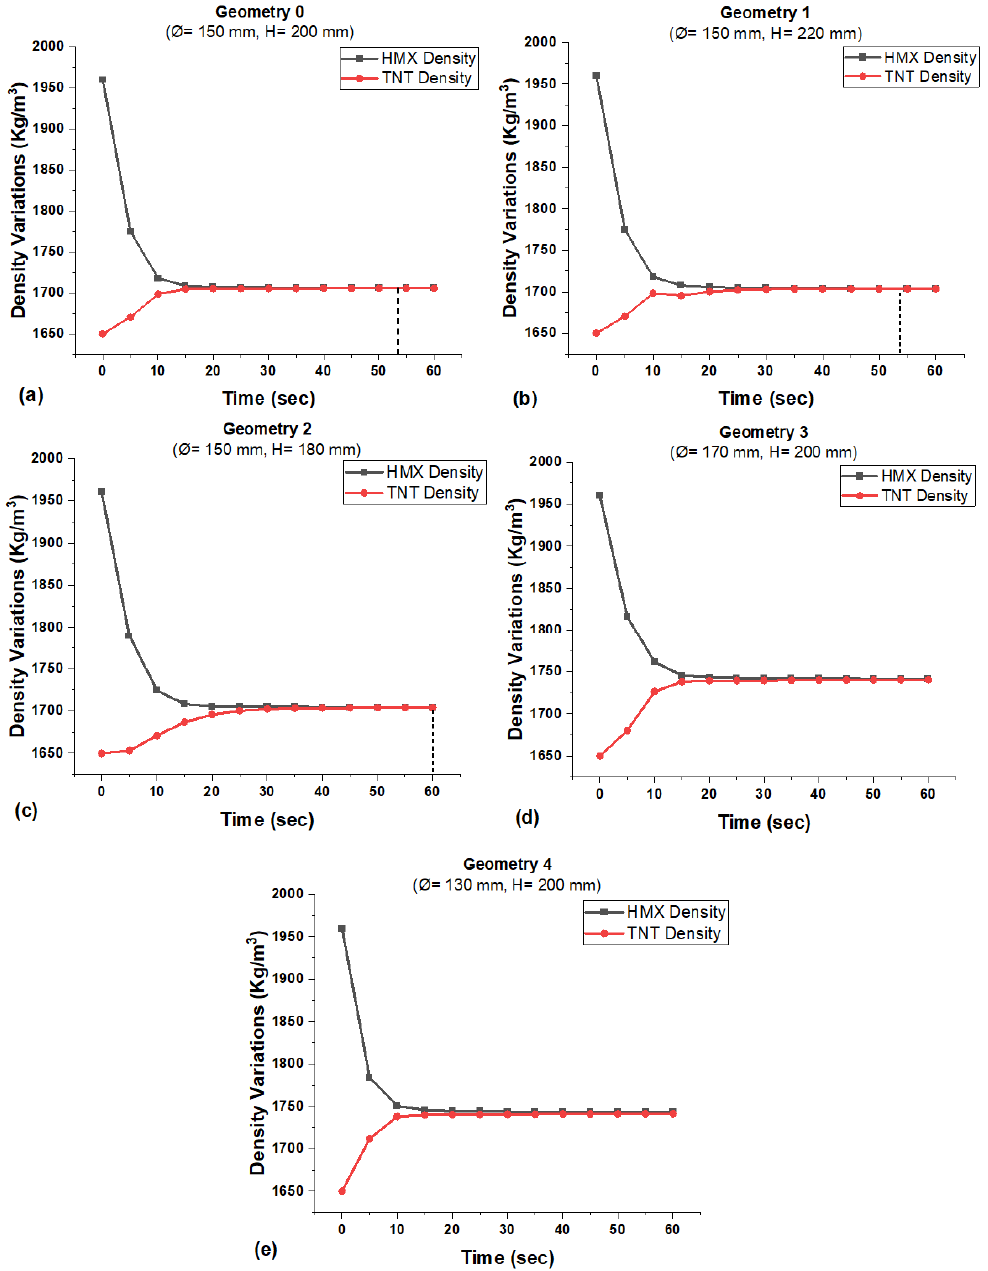
Figure 16. Plots of density variations from ( a – e ) over different vessel geometries.